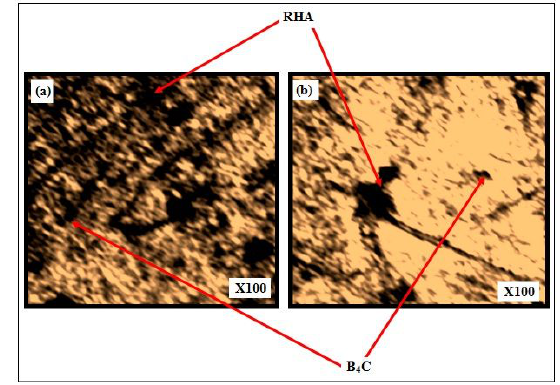
Figure 5: Microstructure of Al/RHA/B 4 C hybrid metal matrix compos-